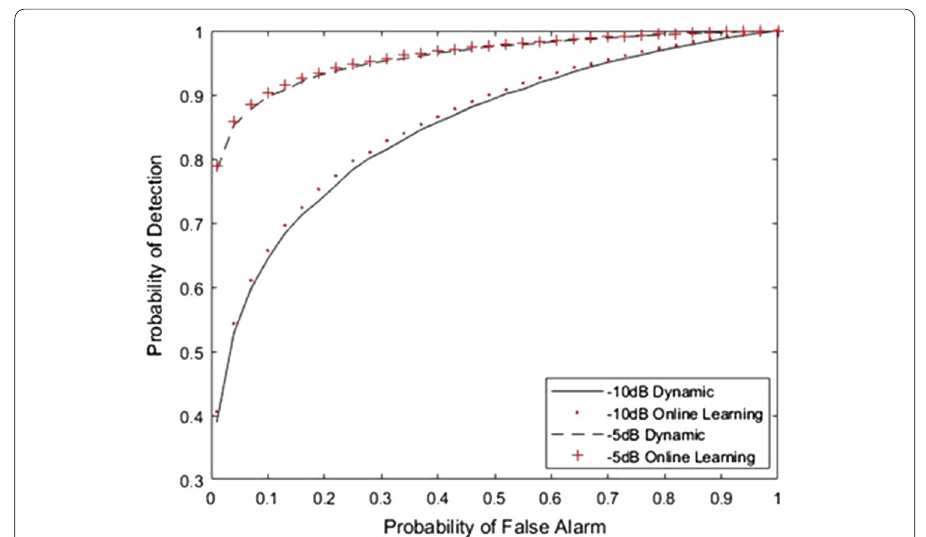
Fig. 7 ROC ( P d vs P fa ) of energy detector sensing under Rician fading channel ( K